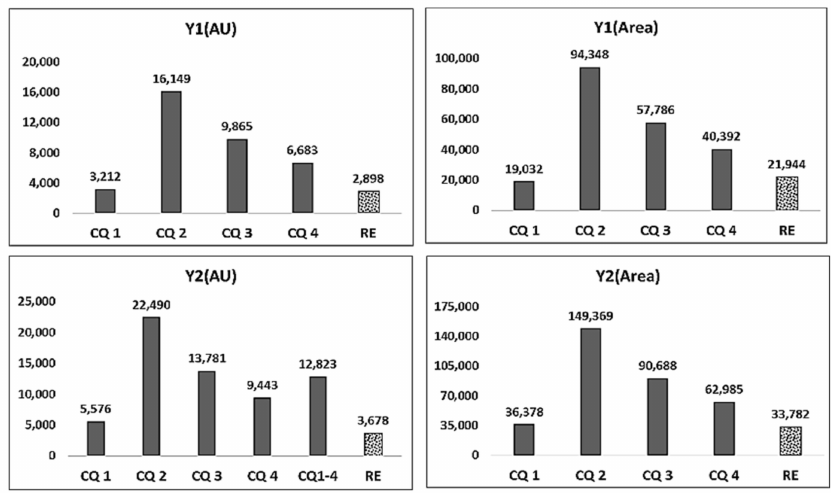
Figure 10. Comparison of experimental results in terms of standard